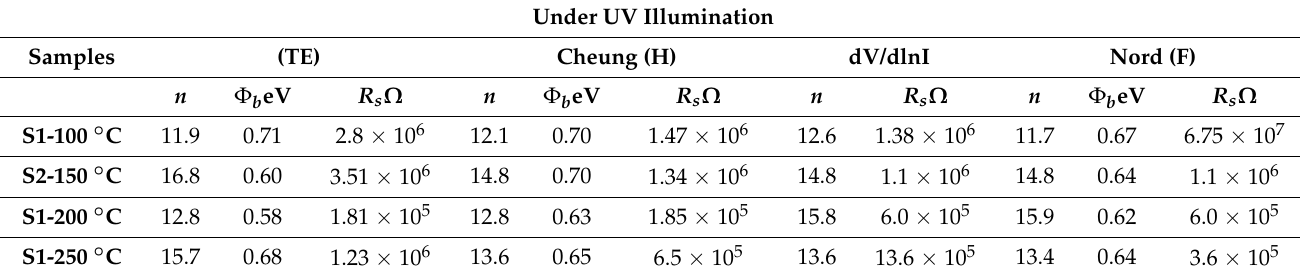
Table 3. The calculated ideality factor, barrier height, and series resistance of MoO 3 /Si under UV illumination at di ff erent preparation temperatures were obtained from the various methods.